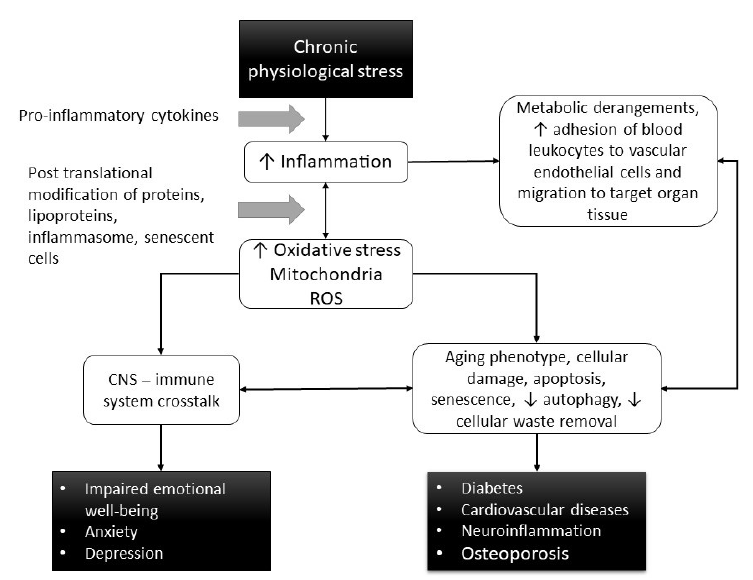
Figure 3. Complex understanding of the mechanism of damage caused by oxidative stress.